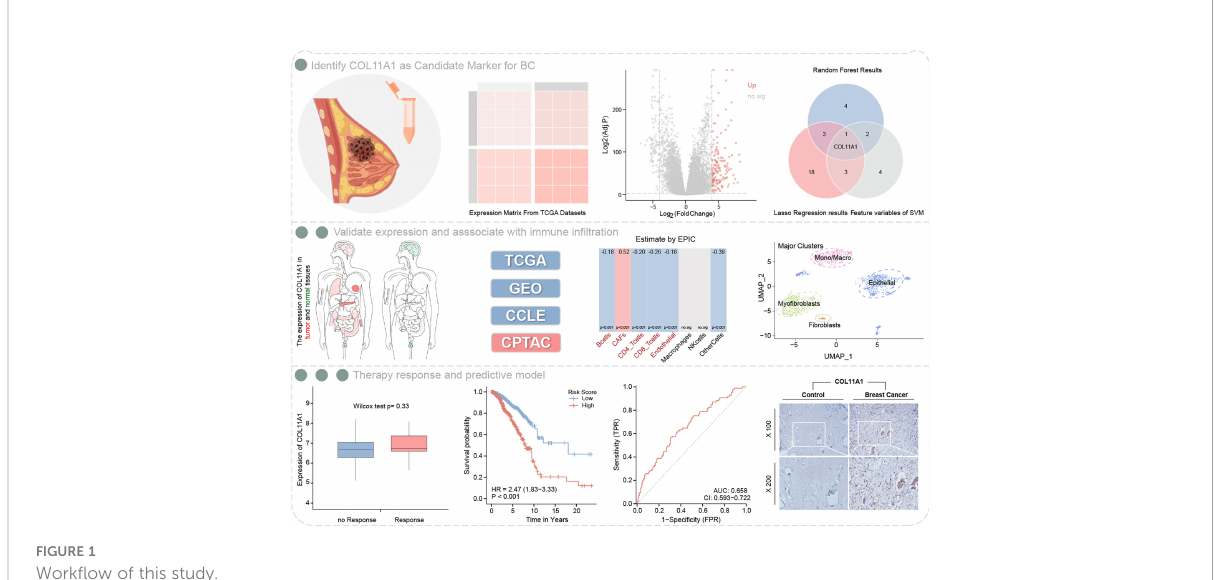
FIGURE 1 Work fl ow of this